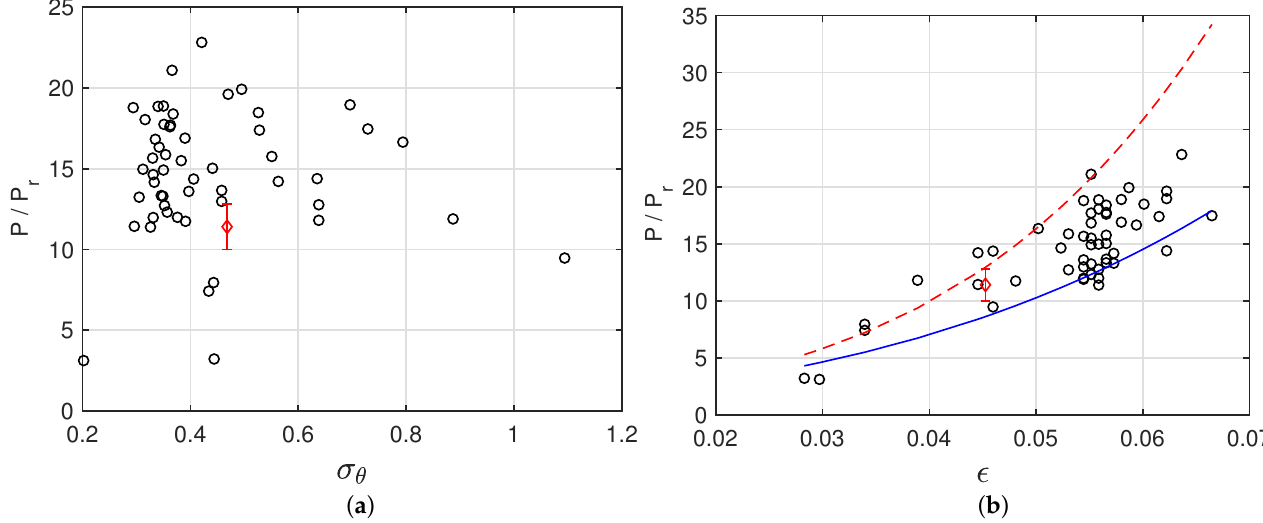
Figure 7. Probability of extreme waves normalized with the Rayleigh probability P / P r as a function of angular spreading σ θ ( a ), and wave steepness (cid:101) ( b ). The red diamond (cid:5) indicates case #16 (Louis Majesty accident), with error bars indicating a 95% confidence interval. The blue line in ( b ) indicates the theoretical probability estimated from the second-order Tayfun distribution. The red dashed line indicates the theoretical probability estimated from the third-order Tayfun